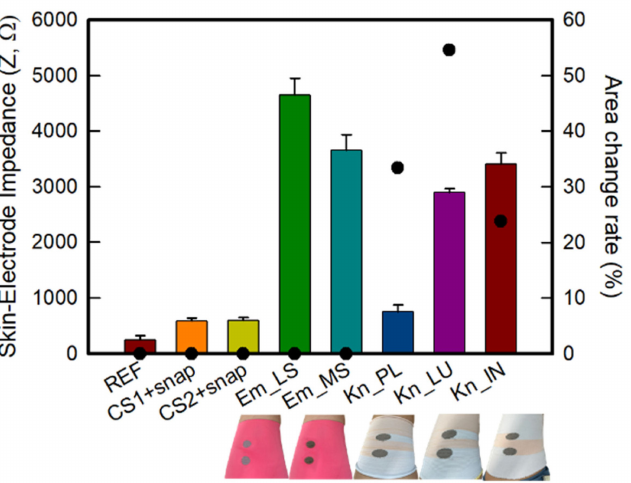
Figure 5. Skin-electrode impedance and area change rate of textile-based dry electrodes with various